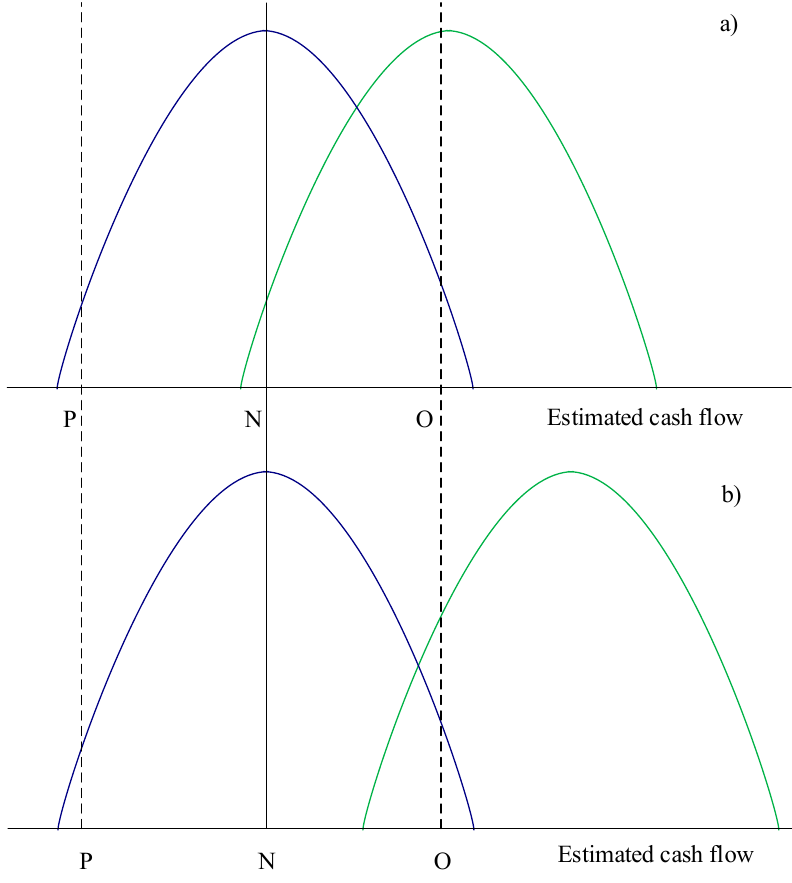
Figure 2. Two forecasts for future level of cash flows–for each class of agents—A (with green) and B (with blue). The two classes estimate the level of indicator (the estimated cash flow) through its probability distribution. The forecast made by one class of agents (B—in the left, with blue) is better than the second one (A—in the right, with green). In ( a ), if the realized cash flow is N (from normal, very plausible for the first class of agents’ forecast), it can be interpreted by the second class of agents as an unfavorable scenario of evolution (but still plausible, according to their forecast). A realized cash flow equal to O (from optimistic) should confirm the good forecast made by class A (even it is only a relatively unusual good performance based on the forecast made by class B). ( b ) depicts an even greater dissonance between the two forecasts. In this case, if the realized cash flow is N, class A can realize that the forecast was indeed wrong, but, also, they can consider that an extreme event occurred.